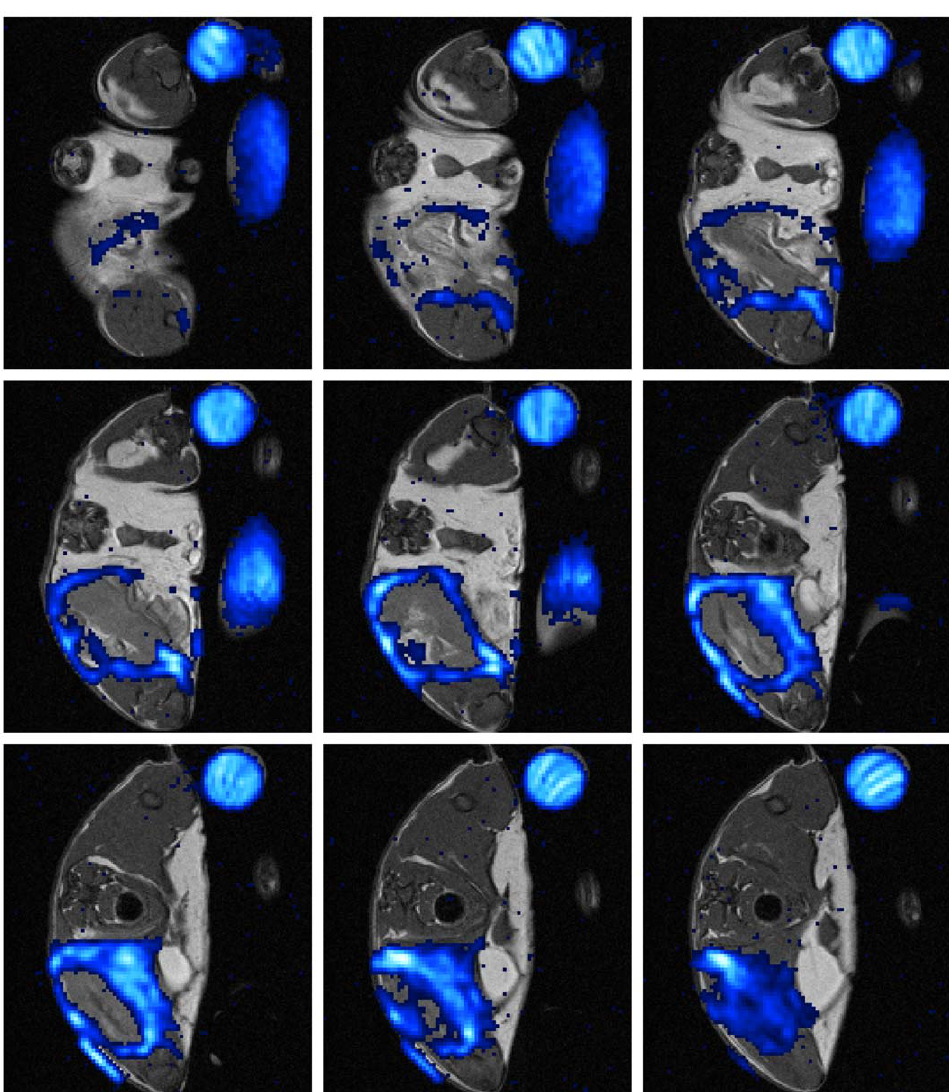
Figure 4. Representative MR-slice series showing the hollow sphere formed by PFC at chronic phase. The depicted mouse received PFC at day 8 post infection. Images were recorded 24 h after administration. 19 F-SSFP CSI overlay on 1 H-TSE image of PFC group mouse shows strong accumulation of PFC at the rim of abscess area. (Slice Thickness: 1 mm, FOV 25 6 25 mm 2 , Co: Control tube filled with PFC dilution, R: right side, L: left side of the imaged mouse).